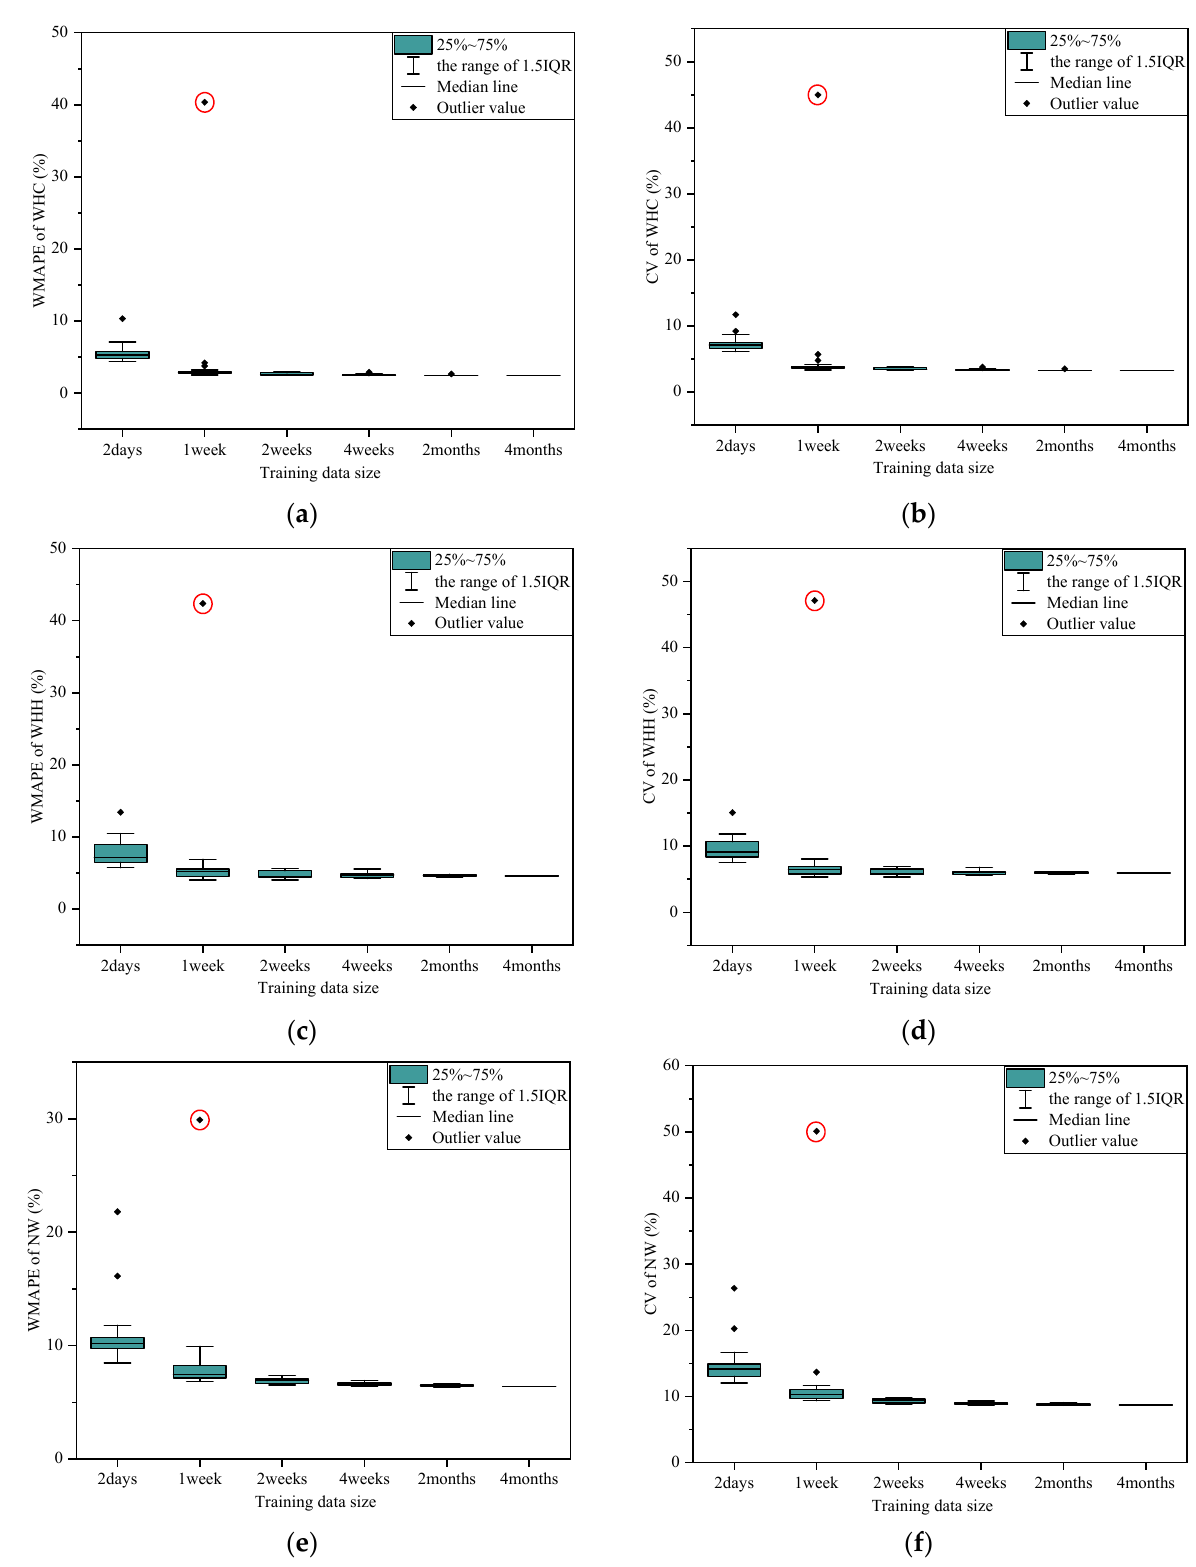
Figure 4. Case A test results with different training data sizes: ( a ) the range of WMPE varies during the WHC; ( b ) the range of CV varies during the WHC; ( c ) the range of WMPE varies during the WHH; ( d ) the range of CV varies during the WHH; ( e ) the range of WMPE varies during the NW; and ( f ) the range of CV varies during the NW.